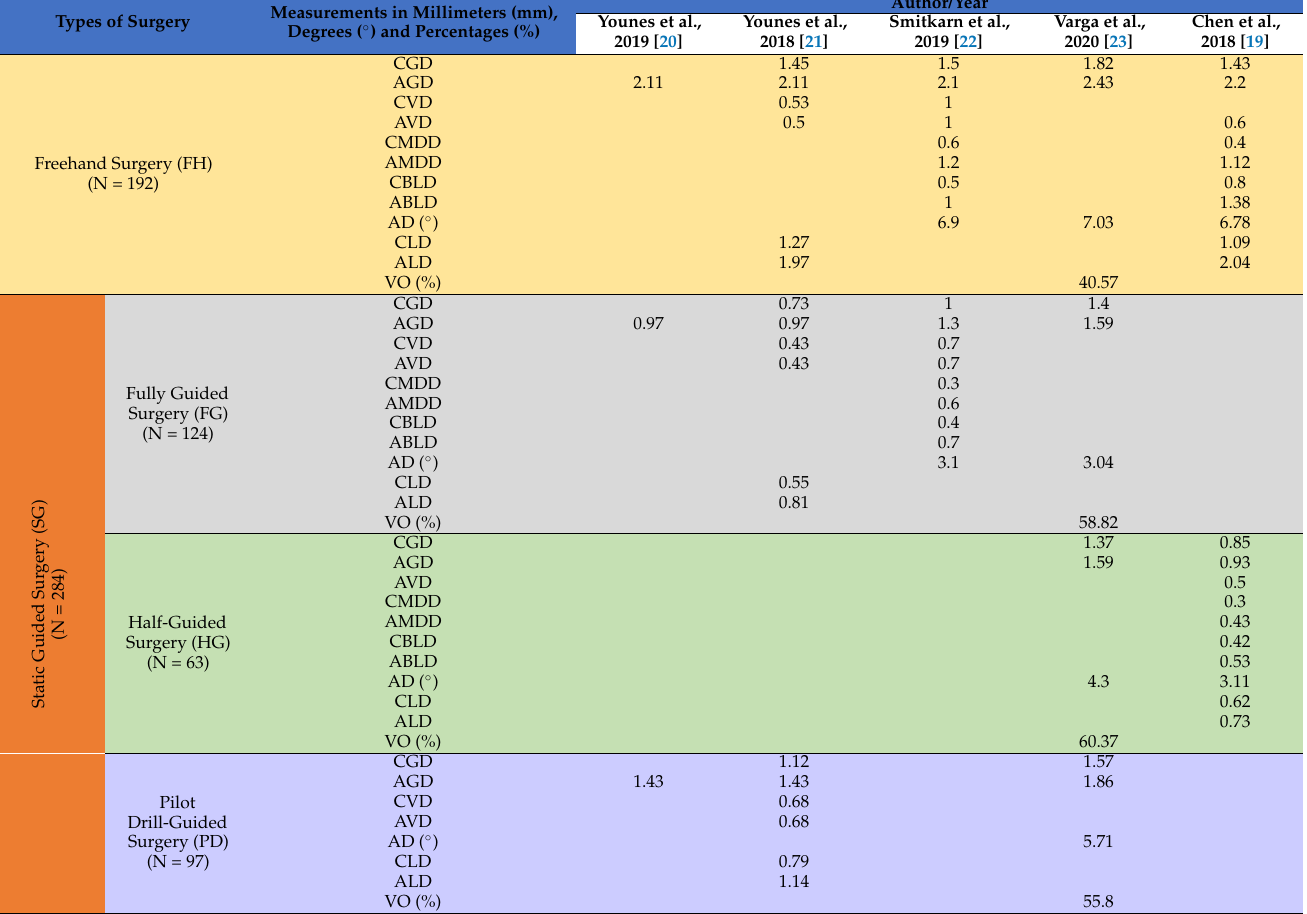
Table 4. Measurements in freehand surgery VS. static guided